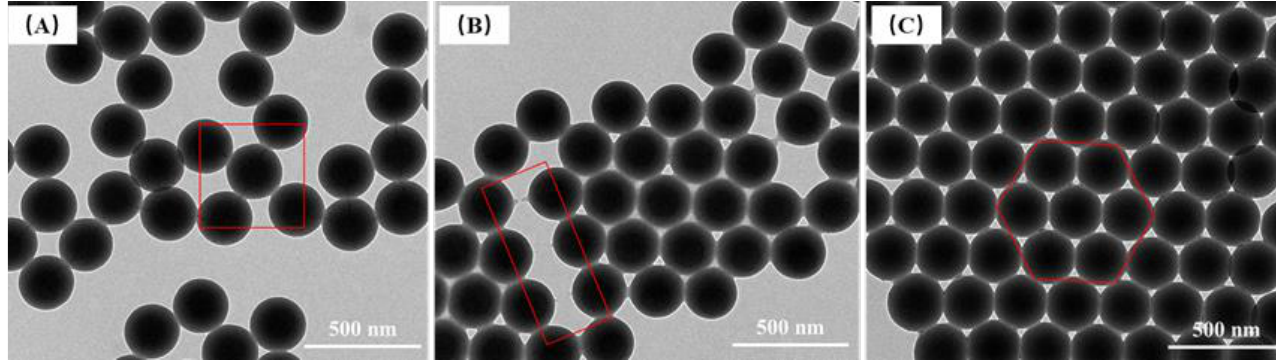
Figure 14. TEM images of P(St-AA) colloidal microspheres to illustrate the contact pattern and arrangement structure. ( A ) the PSt core of the microspheres were connected to each other with a dark line; ( B ) the PAA shell was in a rubber-like state; ( C ) microspheres were arranged in a two-dimensional ordered hexagonal structure by self-assembly.